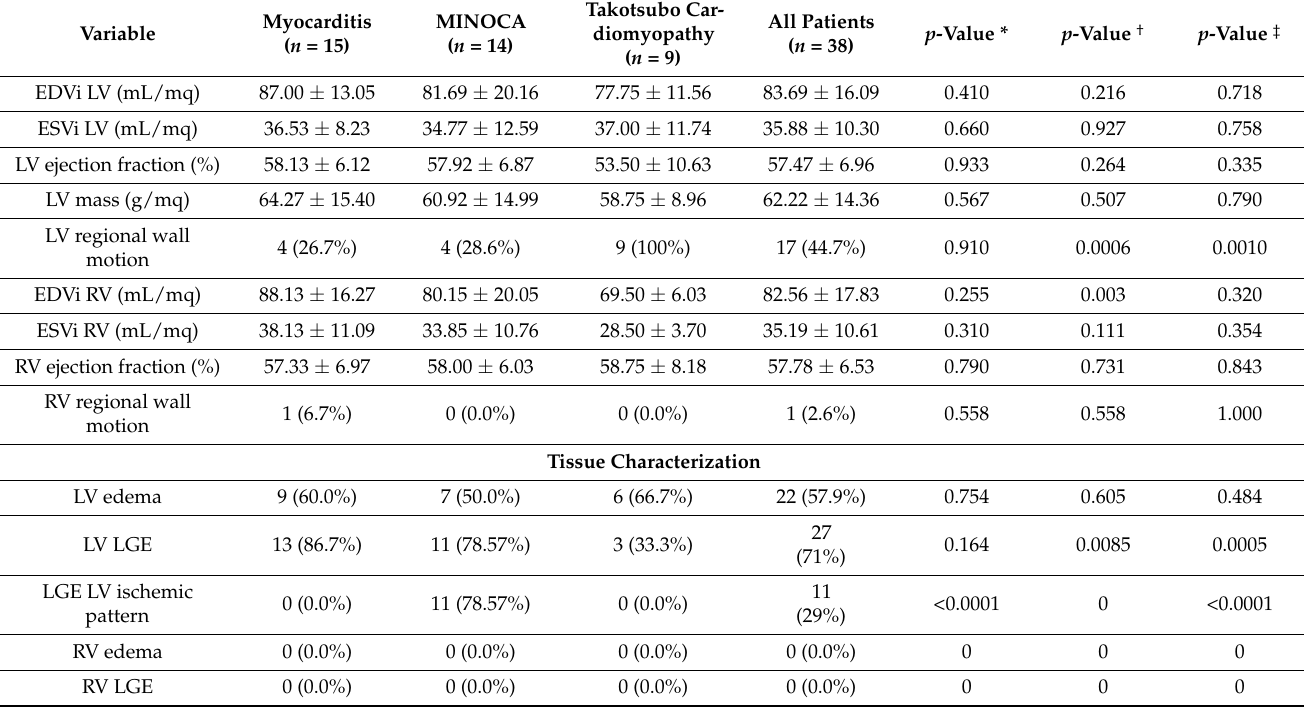
Table 3. Morphological CMR